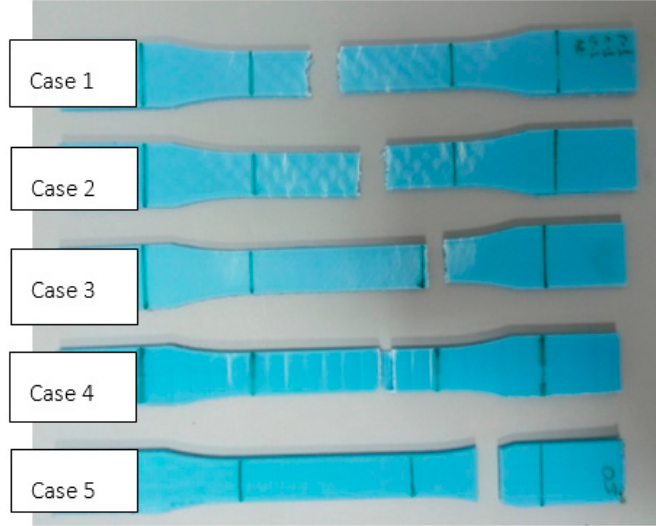
Figure 9. The ABS test specimens tested (one of each type).